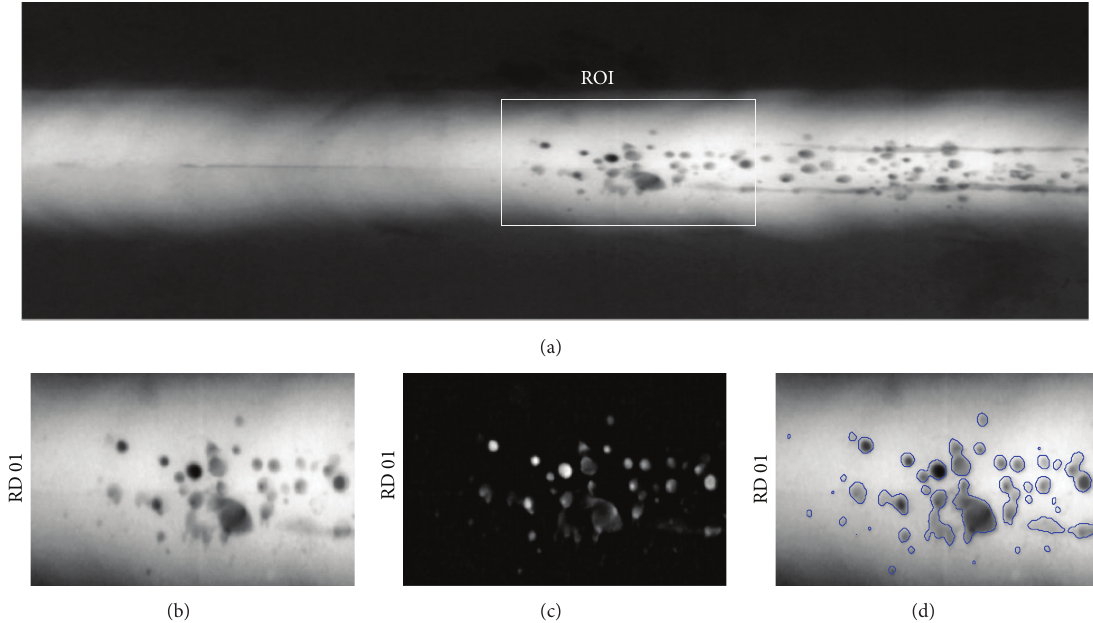
Figure 4: Weld defect detection with the proposed active contour: (a) the whole weld radiogram, (b) ROI selected image, (c) off-center saliency map, and (d) final segmentation with proposed level set active contour (blue color).